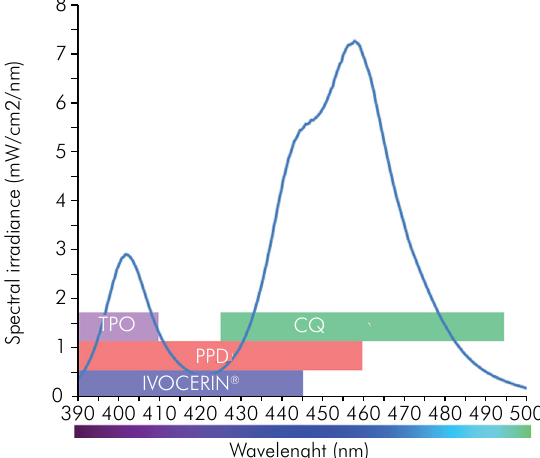
Figure 32. Spectral emission profile of the VALO curing light.